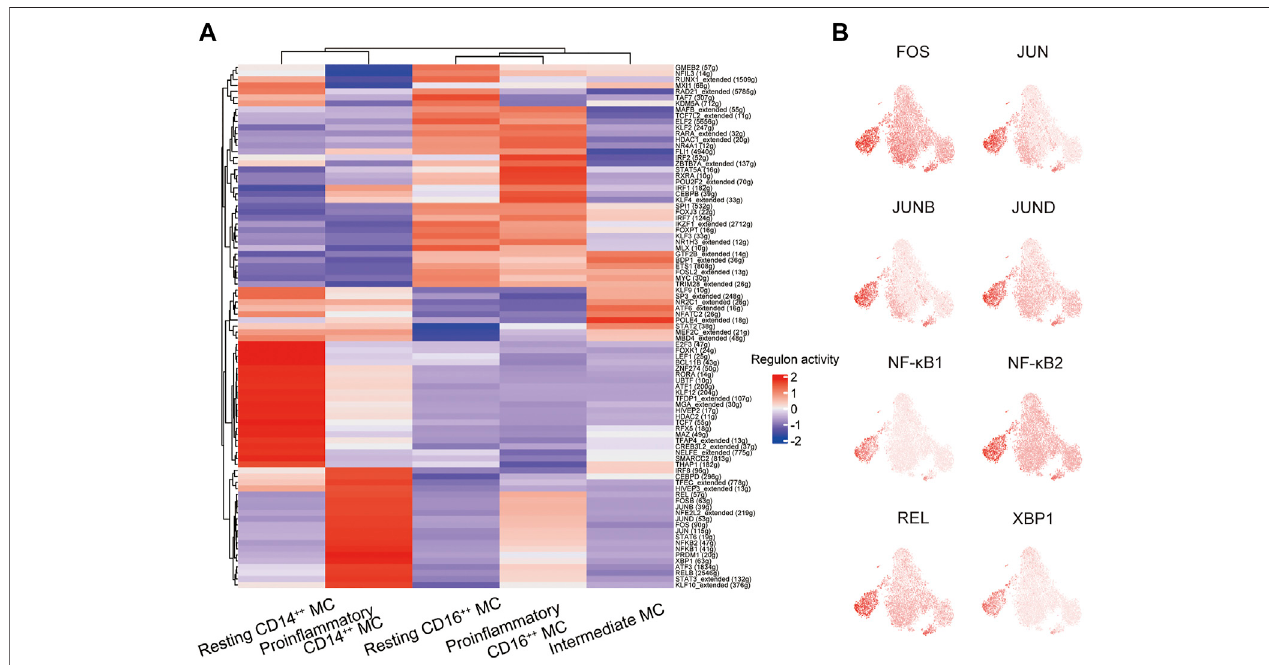
FIGURE5| AgeneregulatorynetworkamongtheTFspredictedbySCENIC. (A) HeatmapoftheAUCscoresoftranscriptionfactors(TFs)inmonocytesubsets,as estimated using SCENIC. (B) T-sne plots showing the regulon activity of the corresponding TFs (FOS, JUN, JUNB, JUND, NFKB1, NFKB2, REL, and XBP1).